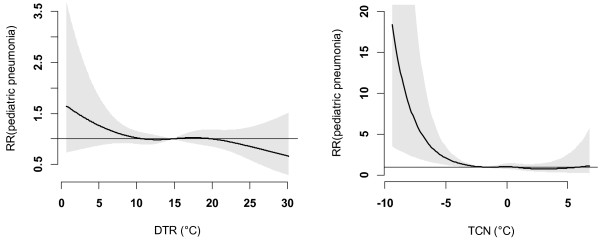
The overall effects of DTR and TCN on pediatric pneumonia in Brisbane, from 2001 to 2010.